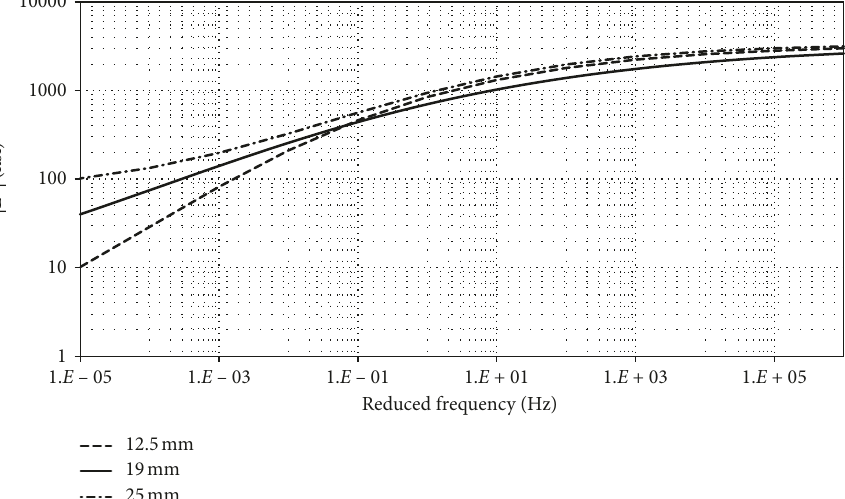
Figure 4: Master curves for SMA mixtures.